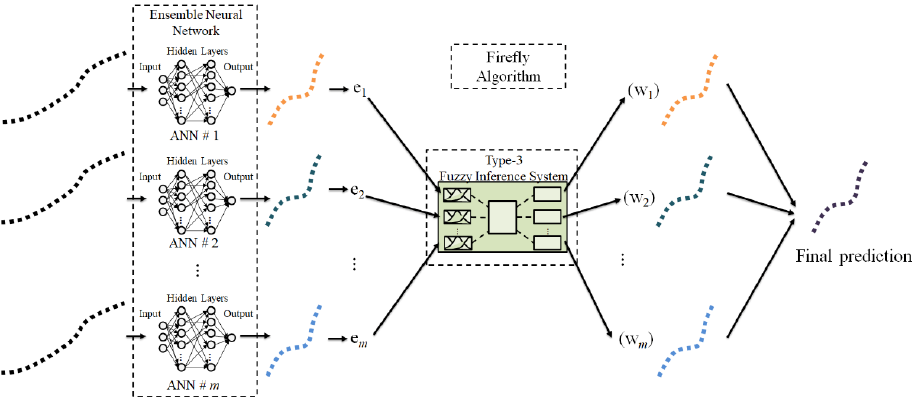
Figure 5. The proposed ENNT3FL ‐ FA.